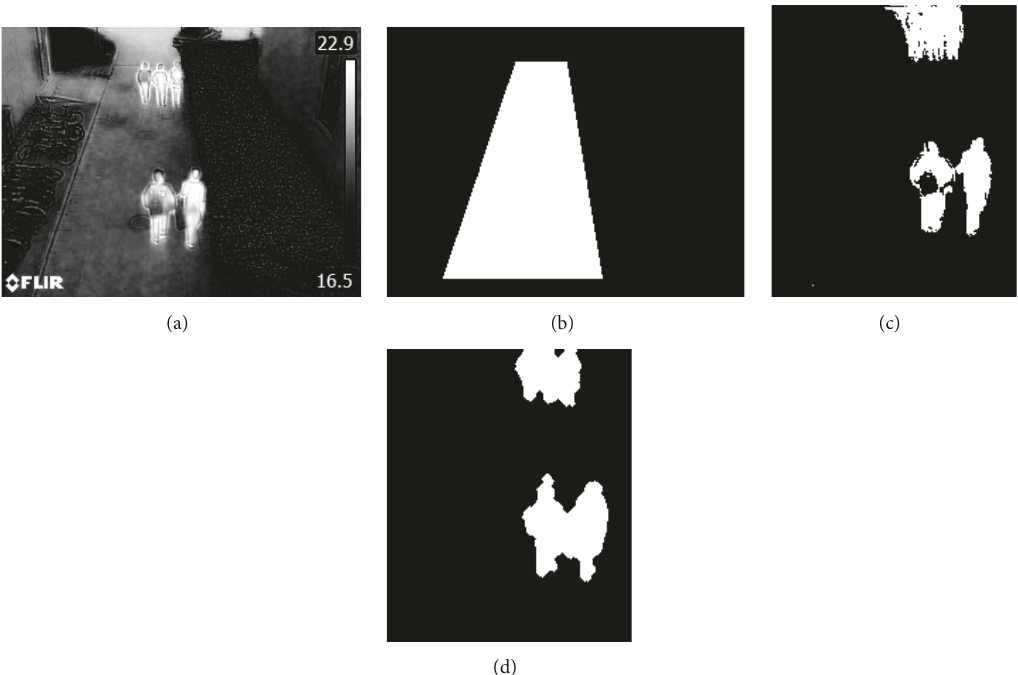
Figure 4: Infrared image processing (a) Original image. (b) ROI mask. (c) Foreground image. (d) Final result.